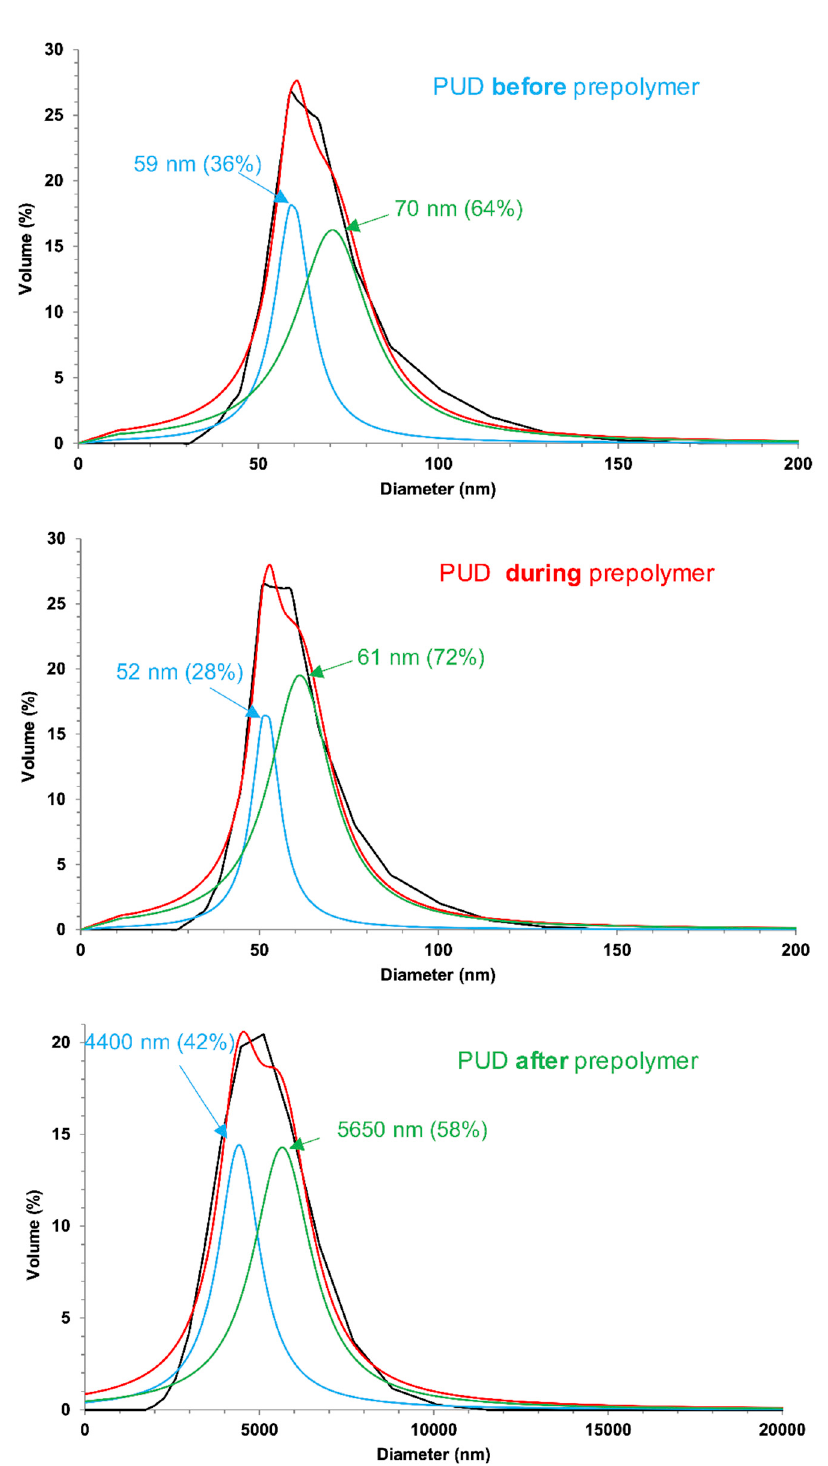
Figure 6. Curve fitting of the particle size distribution curves of the PUDs. Experimental data correspond to the black curves and the curve fitted data correspond to the red